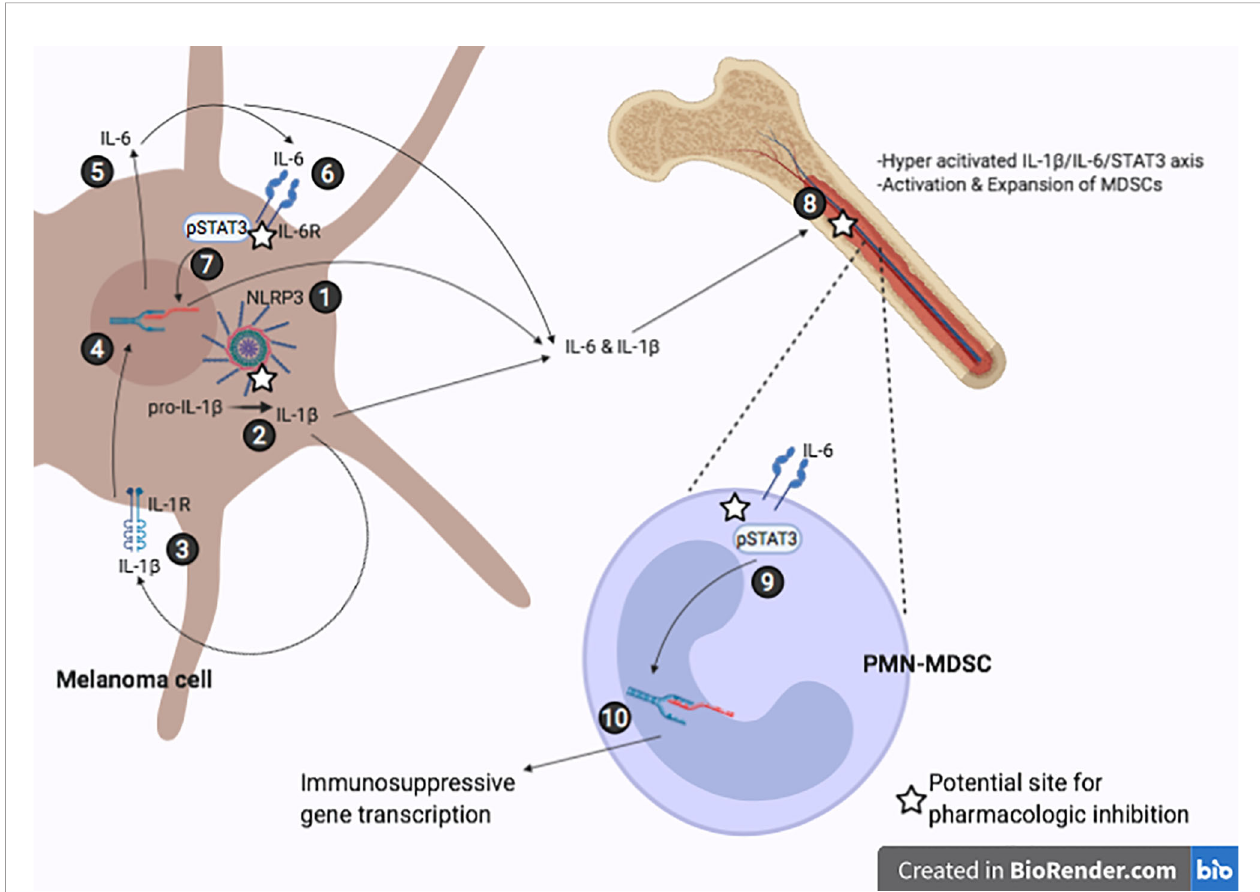
FIGURE 5 | Representative IL-1 b /IL-6/STAT3 axis in melanoma induced immunosuppression. (1) Constitutively active NLRP3 in fl ammasome. (2) NLRP3-mediated cleavage of pro-IL-1 b to mature IL-1 b . (3-4) Secreted IL-1 b binds the IL-1R receptor leading to increased IL-6 transcription. (5-6) IL-6 secreted by melanoma cell binds IL-6R. (7) JAK/STAT3 signaling cascade leads to phosphorylation of STAT3 and induces transcriptional activity leading to more IL-6 production. (8) Tumor- derived IL-1 b and IL-6 travel to bone marrow and promote hyperactivation of IL-1 b /IL-6/STAT3, further inducing melanoma-associated in fl ammation and activation of MDSCs. (9-10) IL-6 signaling in PMN-MDSCs results in nuclear localization of STAT3 and upregulation of immunosuppressive